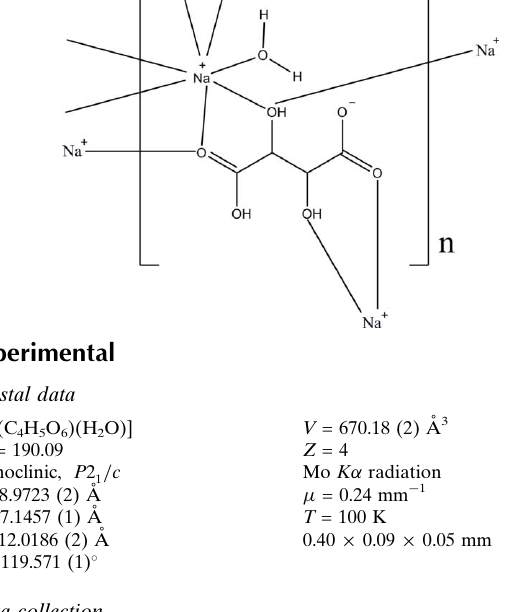
compound, Data collection Bruker SMART APEXII CCD area-detector diffractometer